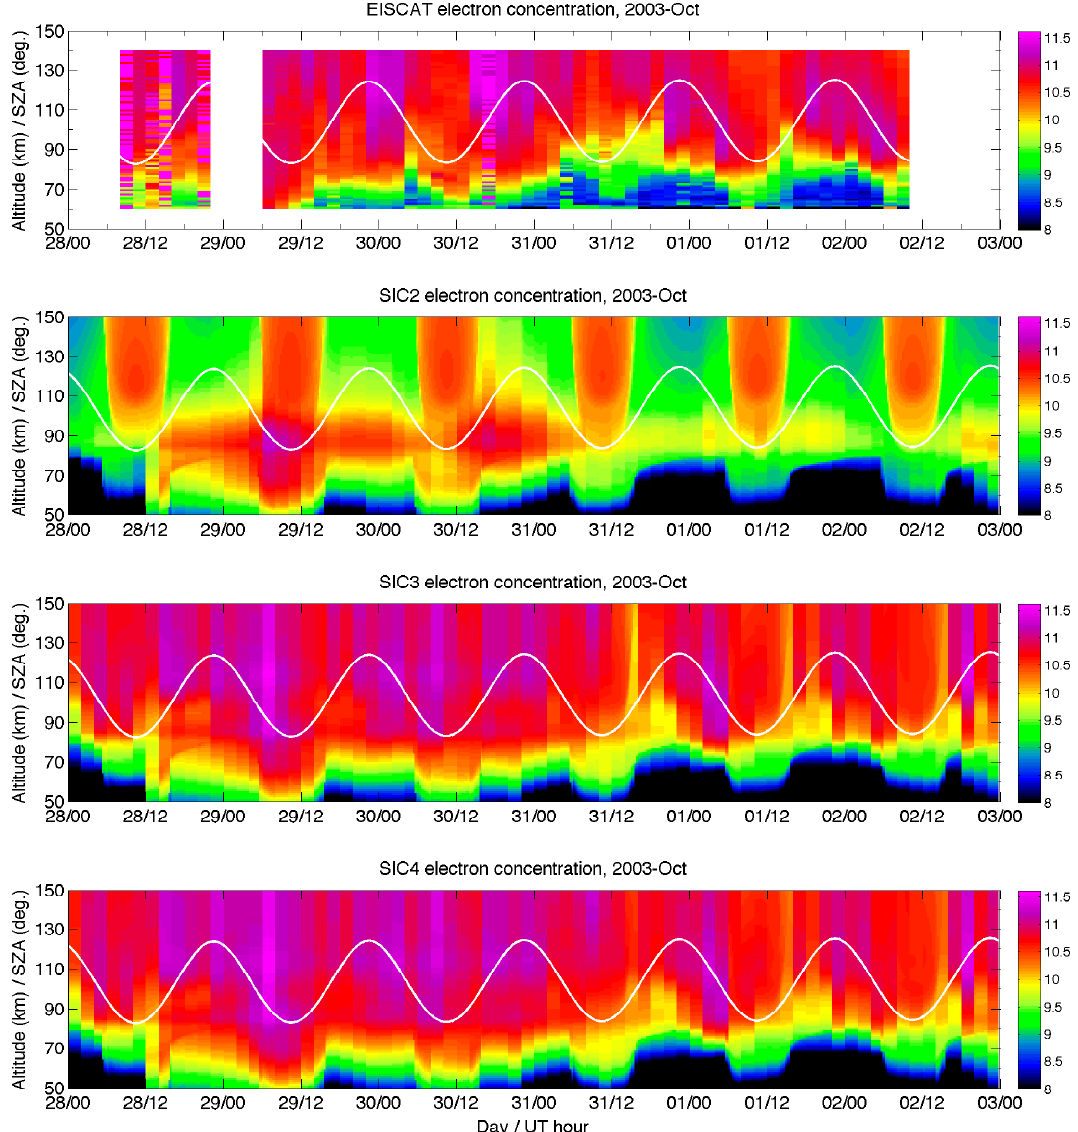
Figure 3. Electron concentrations (10-base logarithm of m − 3 ) from EISCAT and the three SIC model runs for the October–November 2003 event (Case 1). The white line shows the diurnal cycle of the solar zenith angle at the EISCAT Tromsø